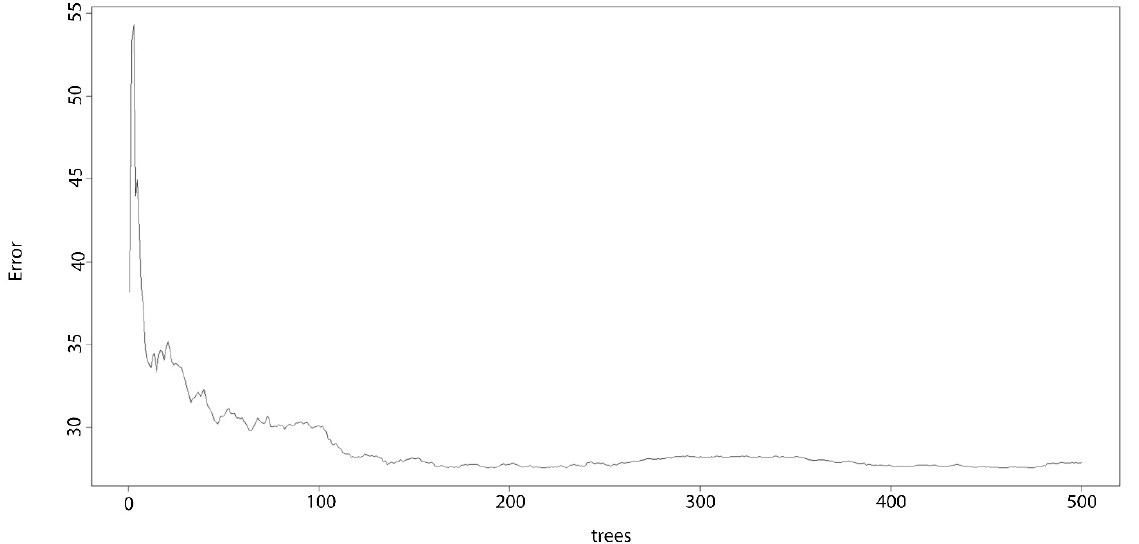
Figure 5. Error variation on the training set for the Random Forest based on the number of trees.